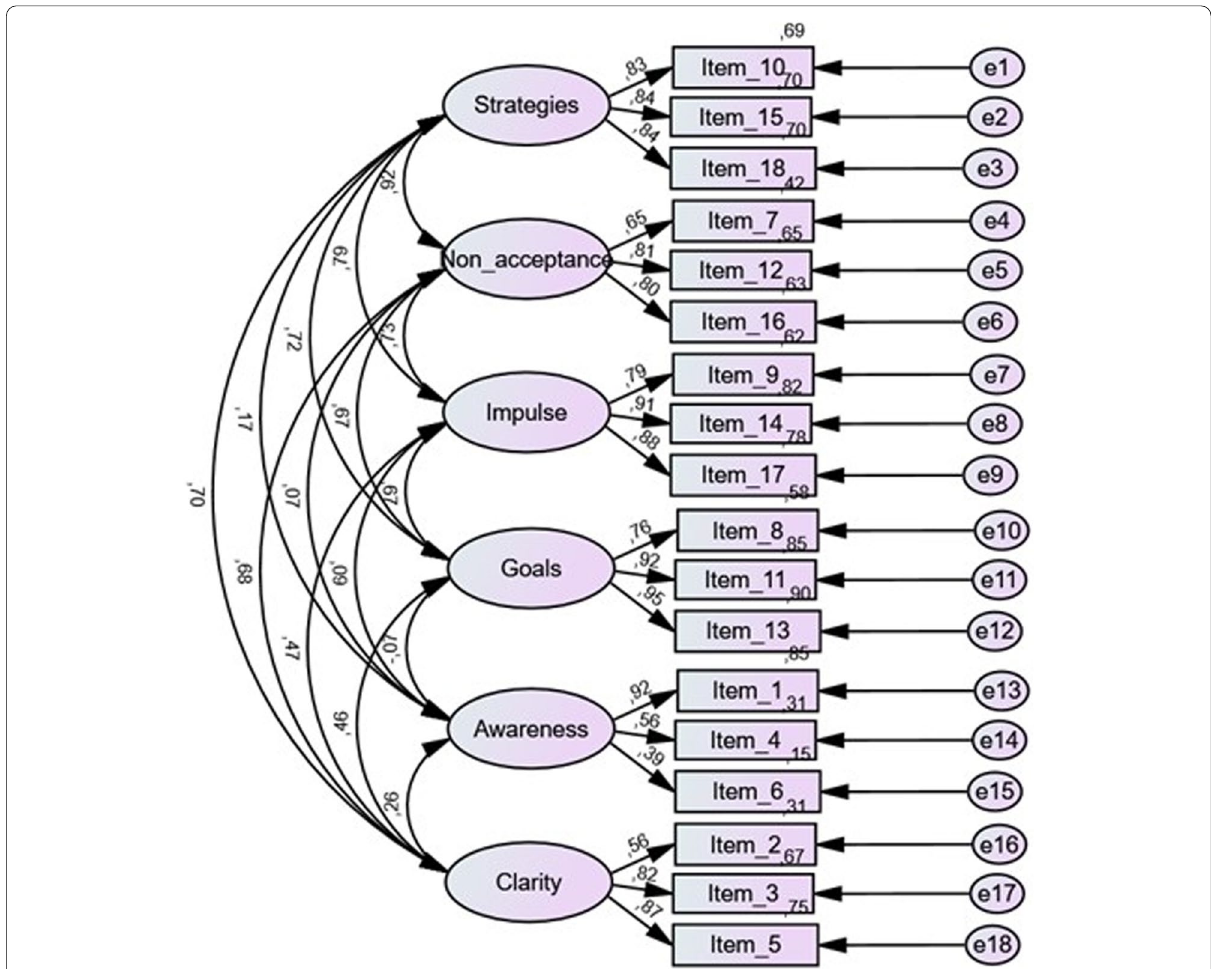
Fig. 1 Correlated six-factor structure of the